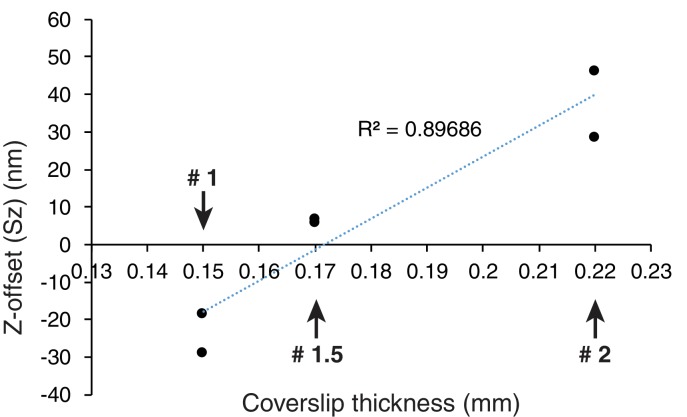
Z-offset changes dependent on coverslip thickness.The plot of measured Z-offset vs mean coverslip thickness. The mean coverslip thickness was 0.15 mm (#1 coverslip), 0.17 mm (#1.5 coverslip), and 0.22 mm (#2 coverslip).